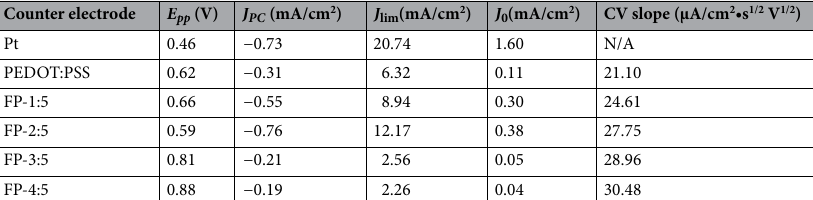
Counter electrode E pp (V) J PC (mA/cm 2